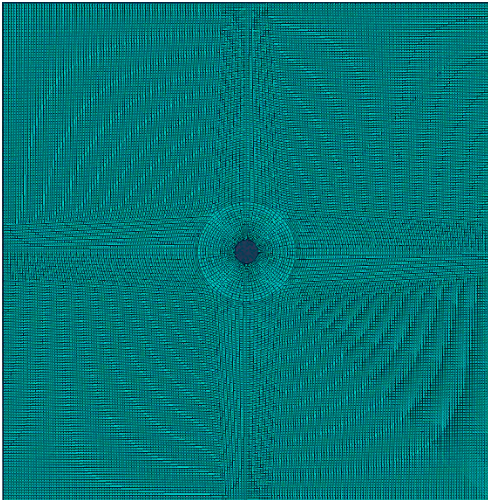
Figure 2. Numerical model diagram.